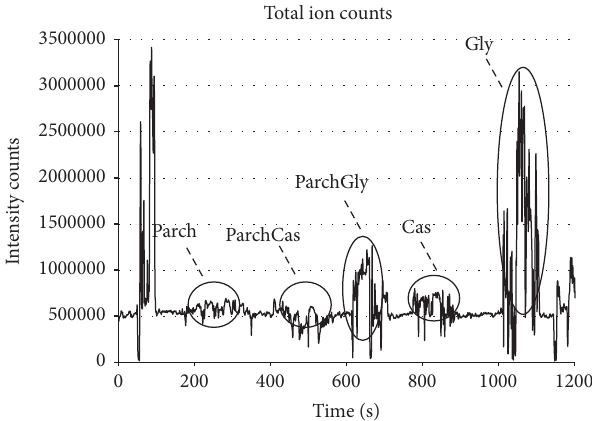
Figure 2: Total ion chromatogram (intensities of all mass spectral peaks belonging to the same scan) of analyzed samples: from time 230 to 300 seconds an untreated parchment sample was positioned in the helium stream; from time 500 to 550 seconds a piece of parchment treated with castor oil was analyzed; from time 630 to 700secondsapieceofparchmenttreatedwithglycerolwasanalyzed; from time 780 to 880 seconds a standard of castor oil was inserted in the gap and analyzed; form time 1020 to 1100 seconds a standard of glycerol was positioned in the helium flux and